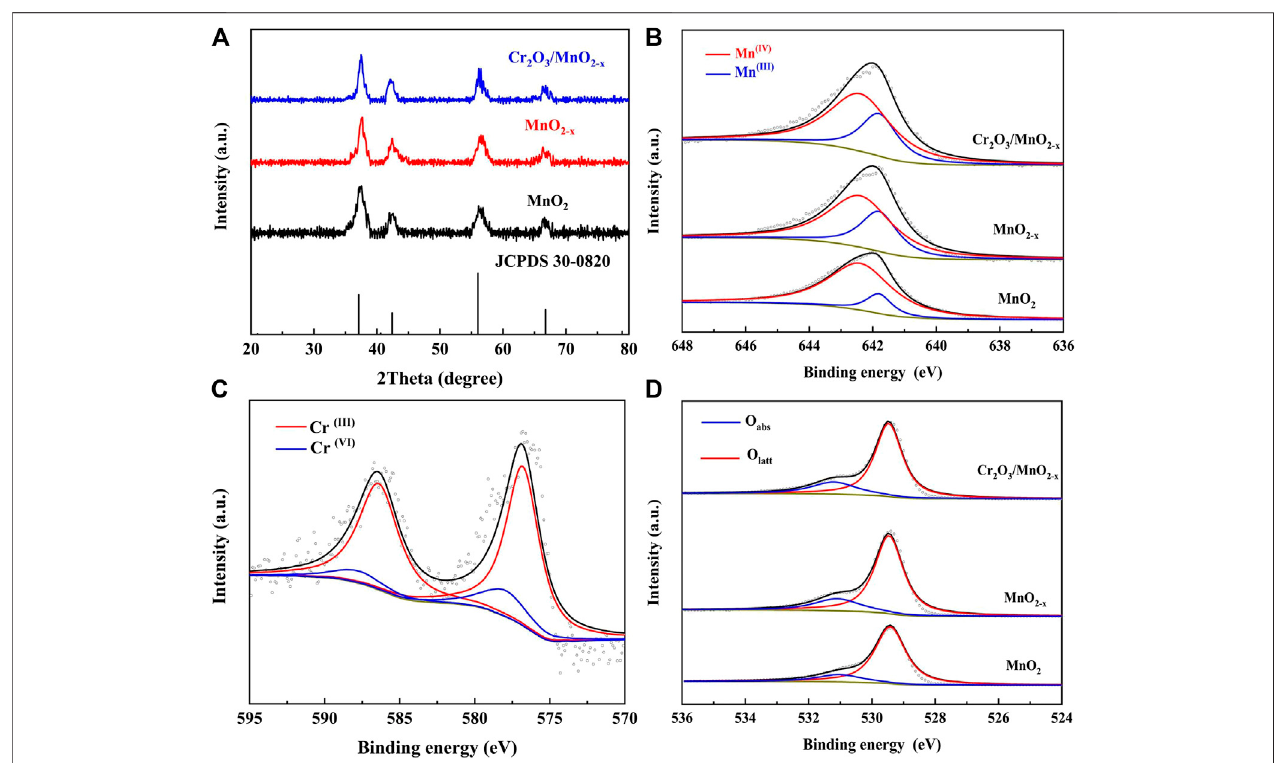
FIGURE2|(A) XRDpatternsfordifferentelectrodematerials; (B) DeconvolutedMn2p3/2spectraofdifferentelectrodematerials; (C) DeconvolutedCr(2p)spectra of Cr 2 O 3 /MnO 2-x ; (D) Deconvoluted O (1s) spectra of different electrode materials.